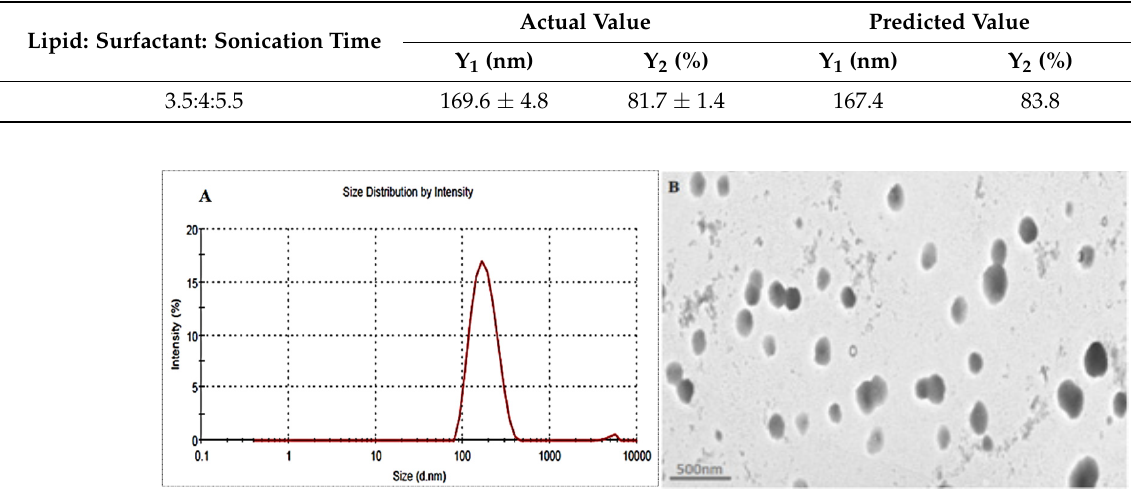
Table 4. Point prediction optimization by central composite design.